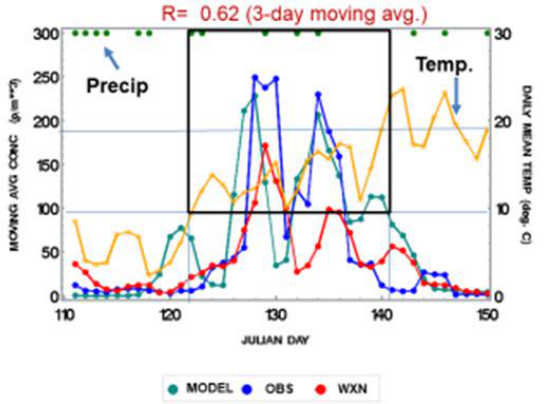
Figure 8. Time series of birch pollen concentration (3-day moving Avg.) simulated by the GEM- MACH model compared with pollen observation (OBS: UdeM) and statistical pollen forecast (from the Weather Network, WXN). The coefficient of correlation between the model and observation is R = 0.62.